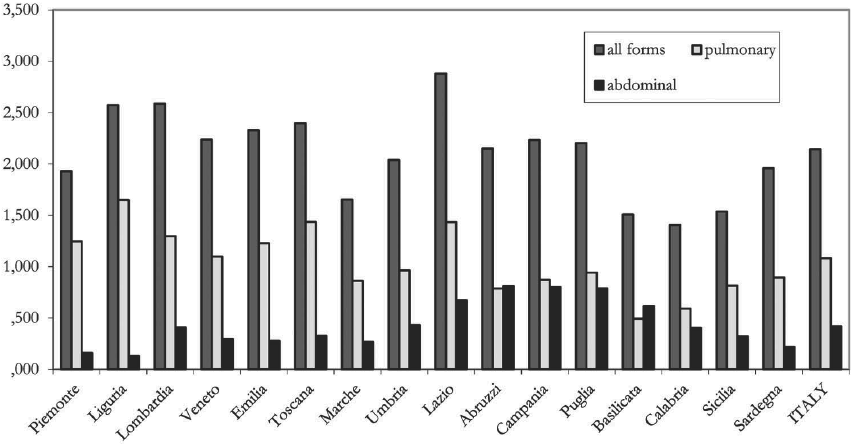
Figure 7 – Mortality rates for tuberculosis (both sexes, per 1,000) in the Italian regions in 1888. air, while for the abdominal form (which mainly affected children) the most common transmission is through the cow’s milk. 31 Nine of the 169 items in the “Statistica delle cause di morte” of 1888, have to be included, ac- cording to the 1942 edition of the Nomenclature nosologiche ...cit. (Istituto di Statistica del Regno d’Italia 1942), in the broader item “tuberculosis in all forms”. However, the two items including the largest number of cases are, in order, the pulmonary and the abdominal form. 32 With no distinction of